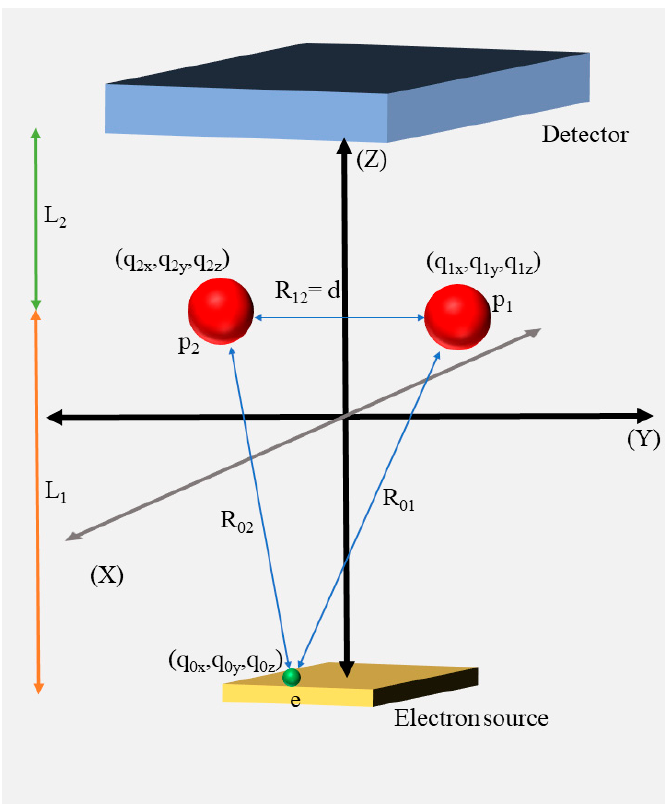
Figure 1. Schematic diagram of our system for two protons case calculations mimicking the interaction between the projectile and the two protons. R 01 , R 02 and R 12 are the distances between electron– proton1, electron–proton2 and proton1–proton2, respectively. Distance between protons R 12 is constant during the simulation. L 1 is the vertical distance between electron source and protons, L 2 is the vertical distance between protons and the detector.